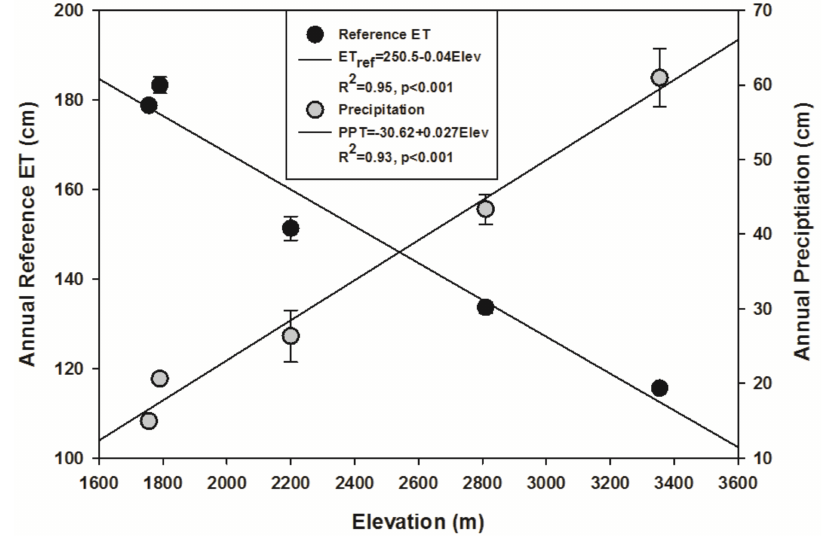
Figure 2. Reference evapotranspiration and precipitation as a function of elevation during 2013–2015 based on the 5 monitoring locations in this study. Table 2. Snow (cm) measured at all 5 monitoring sites during the period 2012–2015 [39]. Percent